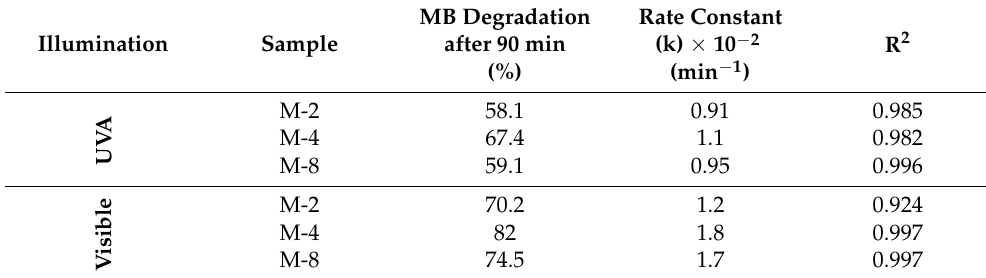
Table 8. Photocatalytic performance of M-2, M-4, and M-8 membranes under UVA and visible light.